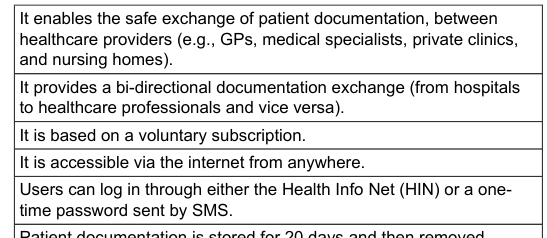
Table 1: The main characteristics of the HIE portal EOCnet.